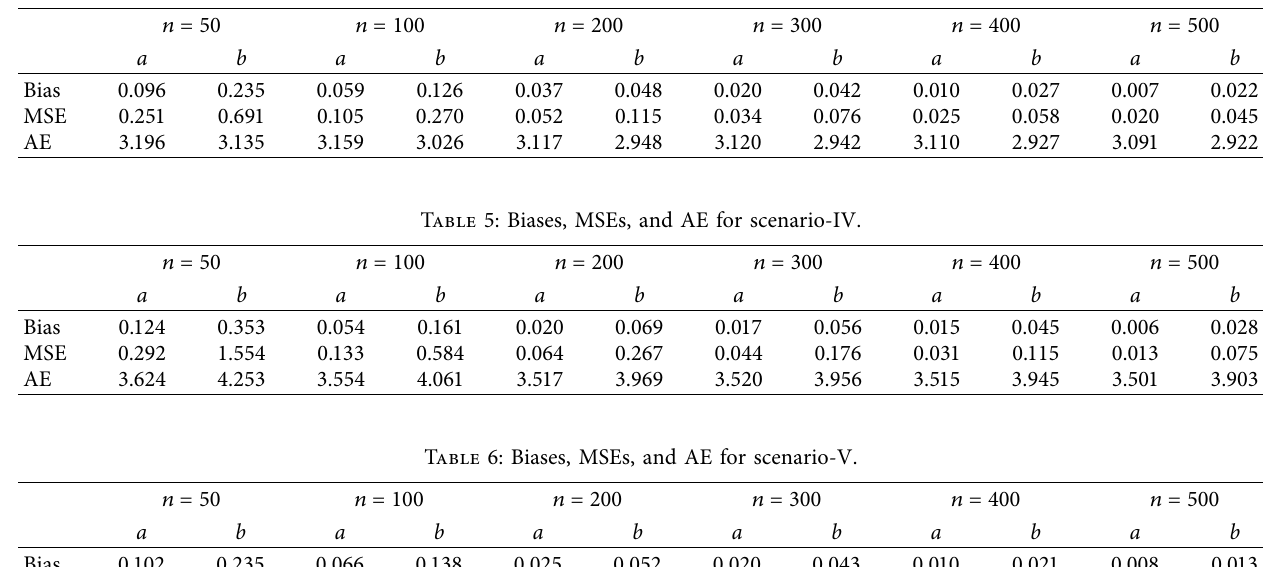
Table 4: Biases, MSEs, and AE for scenario-III.